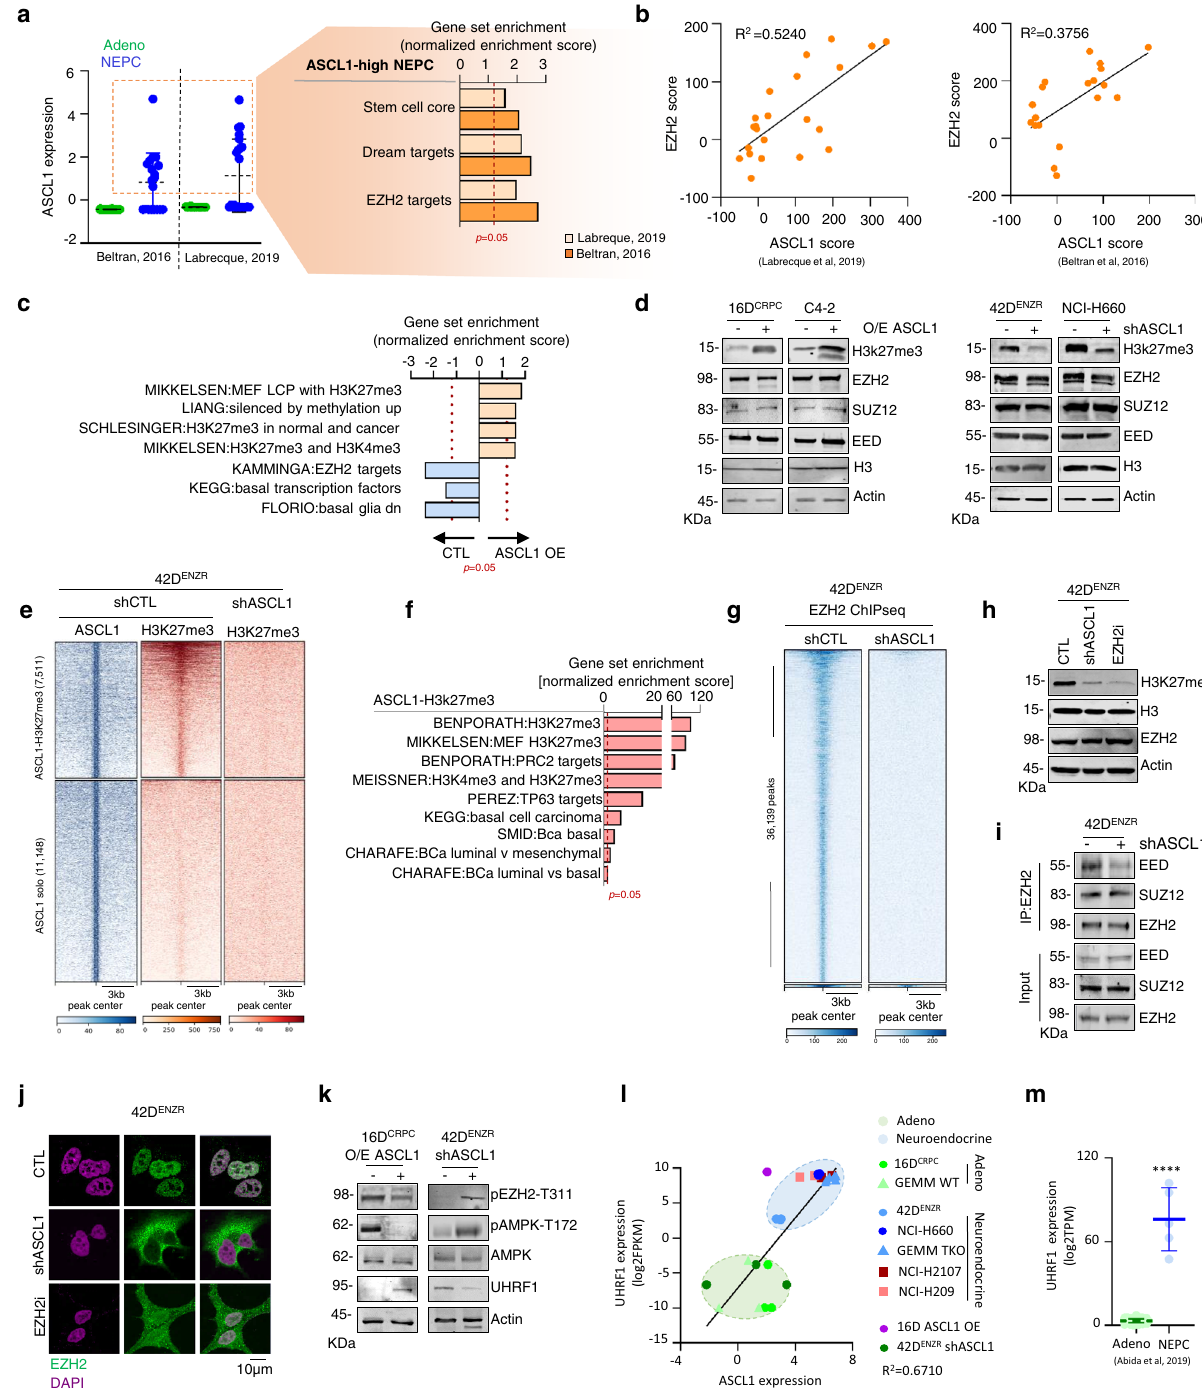
SCHLESINGER:H3K27me3 in normal and cancer MIKKELSEN:H3K27me3 and